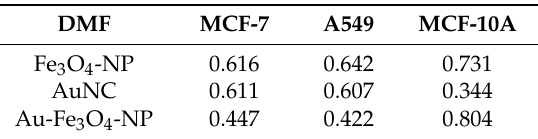
Table 1. DMF values obtained from the radiation dose survival curves of MCF-7, A549 and MCF-10A cells depicted in Figure 10.